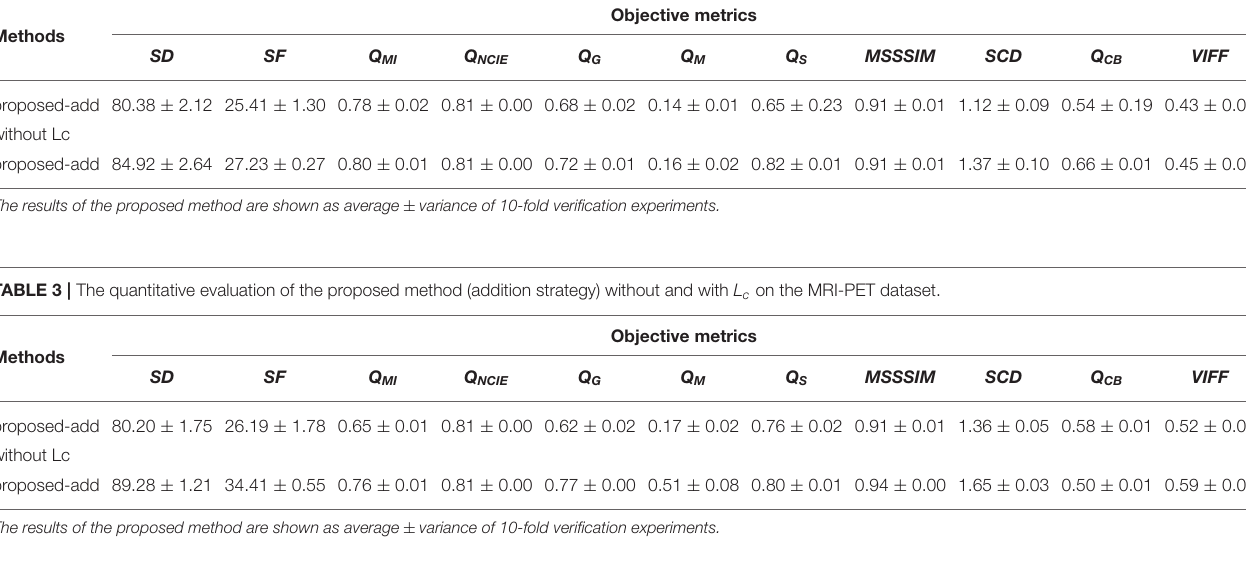
TABLE 2 | The quantitative evaluation of the proposed method (addition strategy) without and with L c on the MRI-CT dataset. Methods